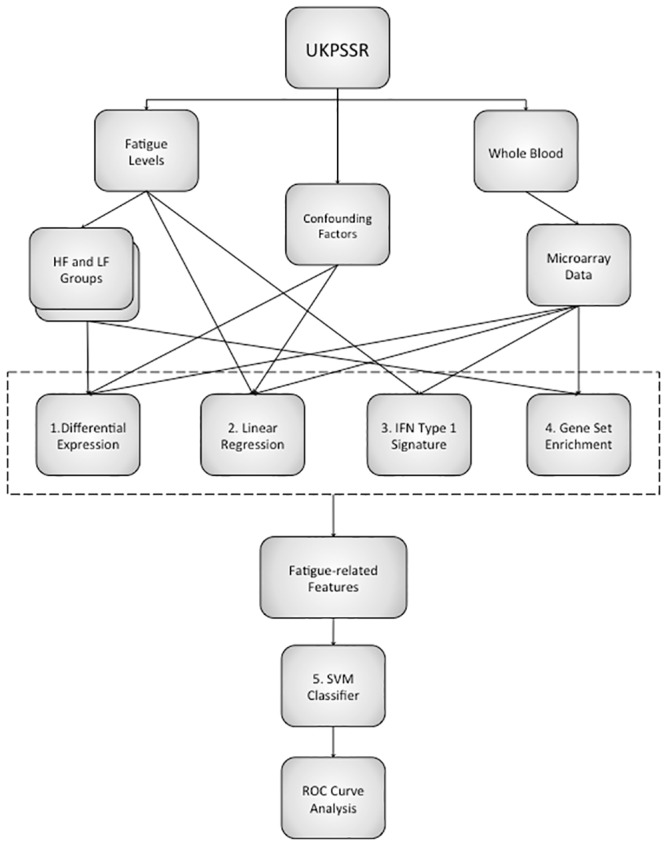
A workflow of the gene expression analysis.The gene expression data were analysed to produce a list of fatigue-related features which were used as inputs for a support vector machine classifier of fatigue. 1. Differentially expressed genes were identified between fatigue groups. 2. Linear regression was used to analyse fatigue as a continuous variable. 3. The interferon type I signature was calculated for all the patients and compared to fatigue levels. 4. Gene set enrichment analysis was carried out using the high and low fatigue groups. 5. A support vector machine classifier was created using fatigue-related features as inputs and its performance assessed using receiver-operator characteristic (ROC) curves.